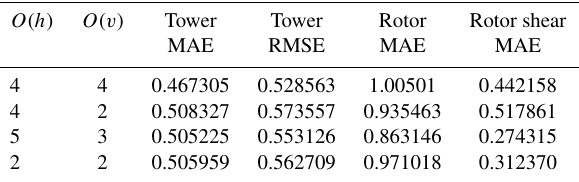
Table 4. Analysis of WRF LES performance using different advec- tion schemes with the Lilly SFS parameterization. Tower Tower Rotor Rotor